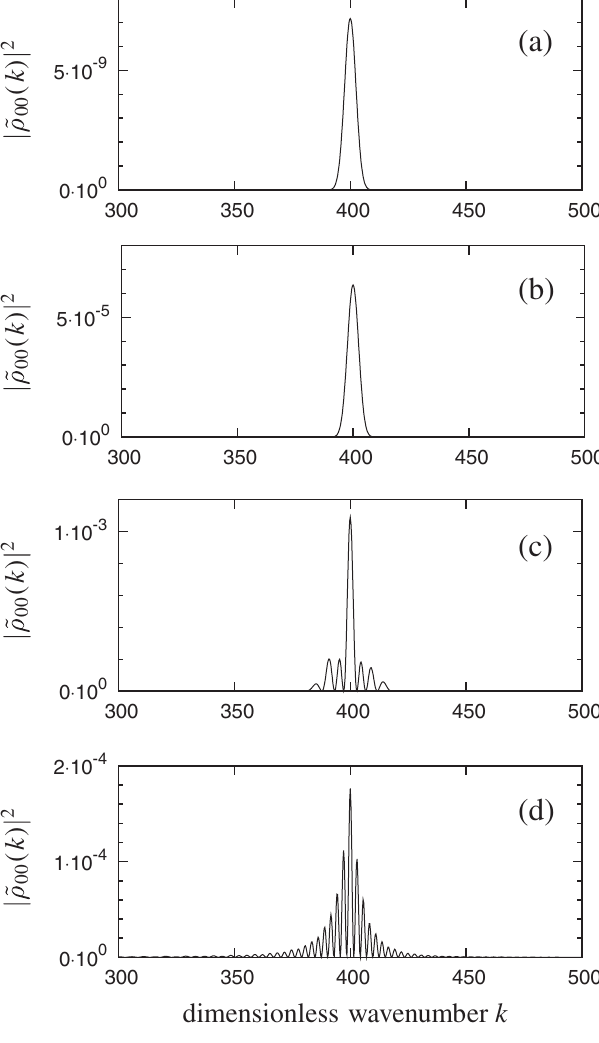
¼ 400 , (cid:9) ¼ 0 : 3 , r 51 ¼ m L